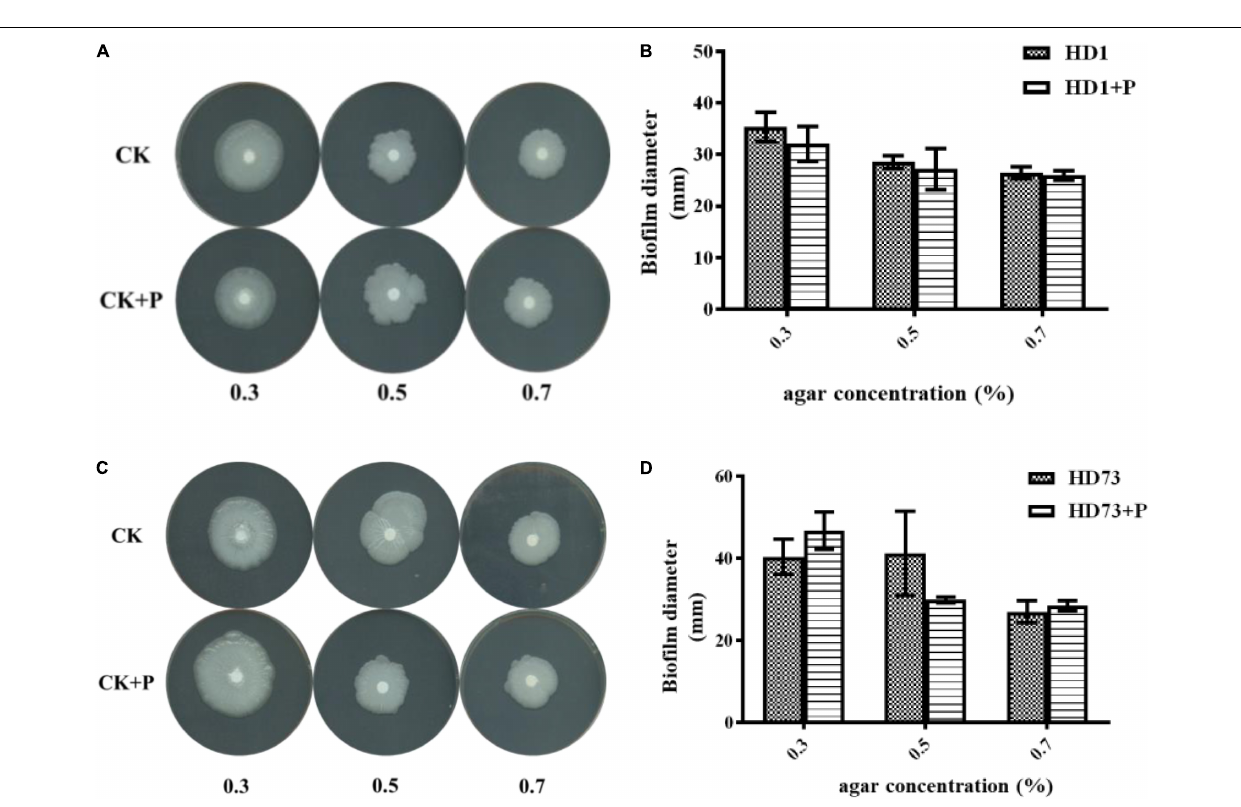
Frontiers in Microbiology |